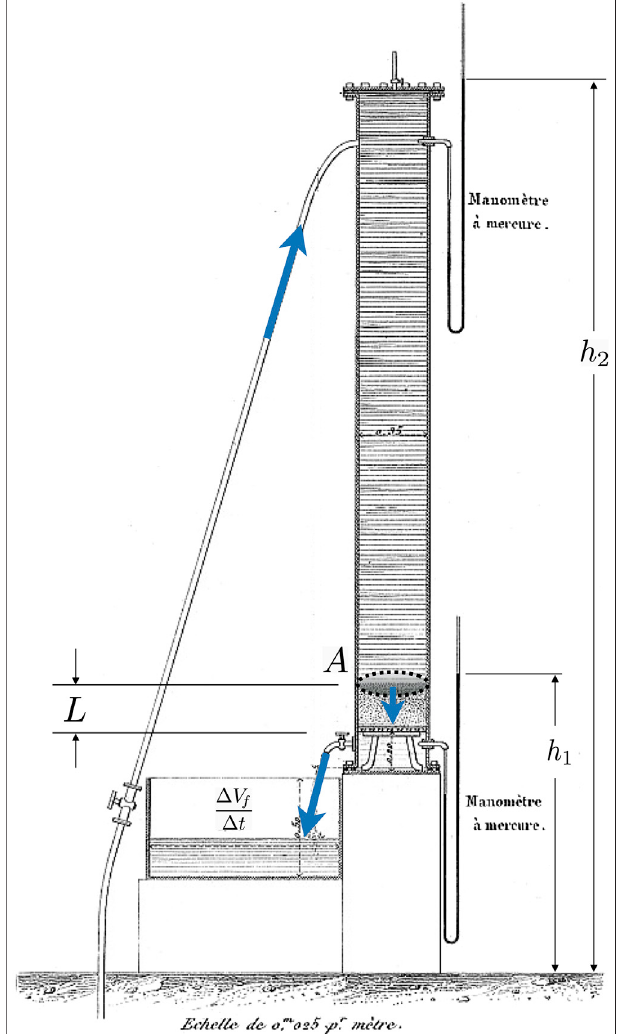
FIGURE1| Themodelofaporousmaterialconsistsofanelasticmatrix- the solid - and a connected pore space. Pores whose connected boundaries are homeomorphic (topologically identical) to spheres are not a part of the connected pore space, as nothing can fl ow through them. The connected pore space is fi lled with a fl uid, whose interactions with the walls of the elastic skeleton provide a much richer phenomenology than elastic/ viscoelasticmodelsofmaterials.Whenaporoussubstanceisintersectedwith a plane, the cross section, whose area is A , will have holes in it. The effective cross-sectional area, A f , is the area of all of these holes. For an isotropic material, the orientation of the intersecting plane does not change the ratio A f / A . The Delesse-Rosiwal law states that this ratio is equal to the ratio of the pore space volume to the total volume i.e. the porosity [40].